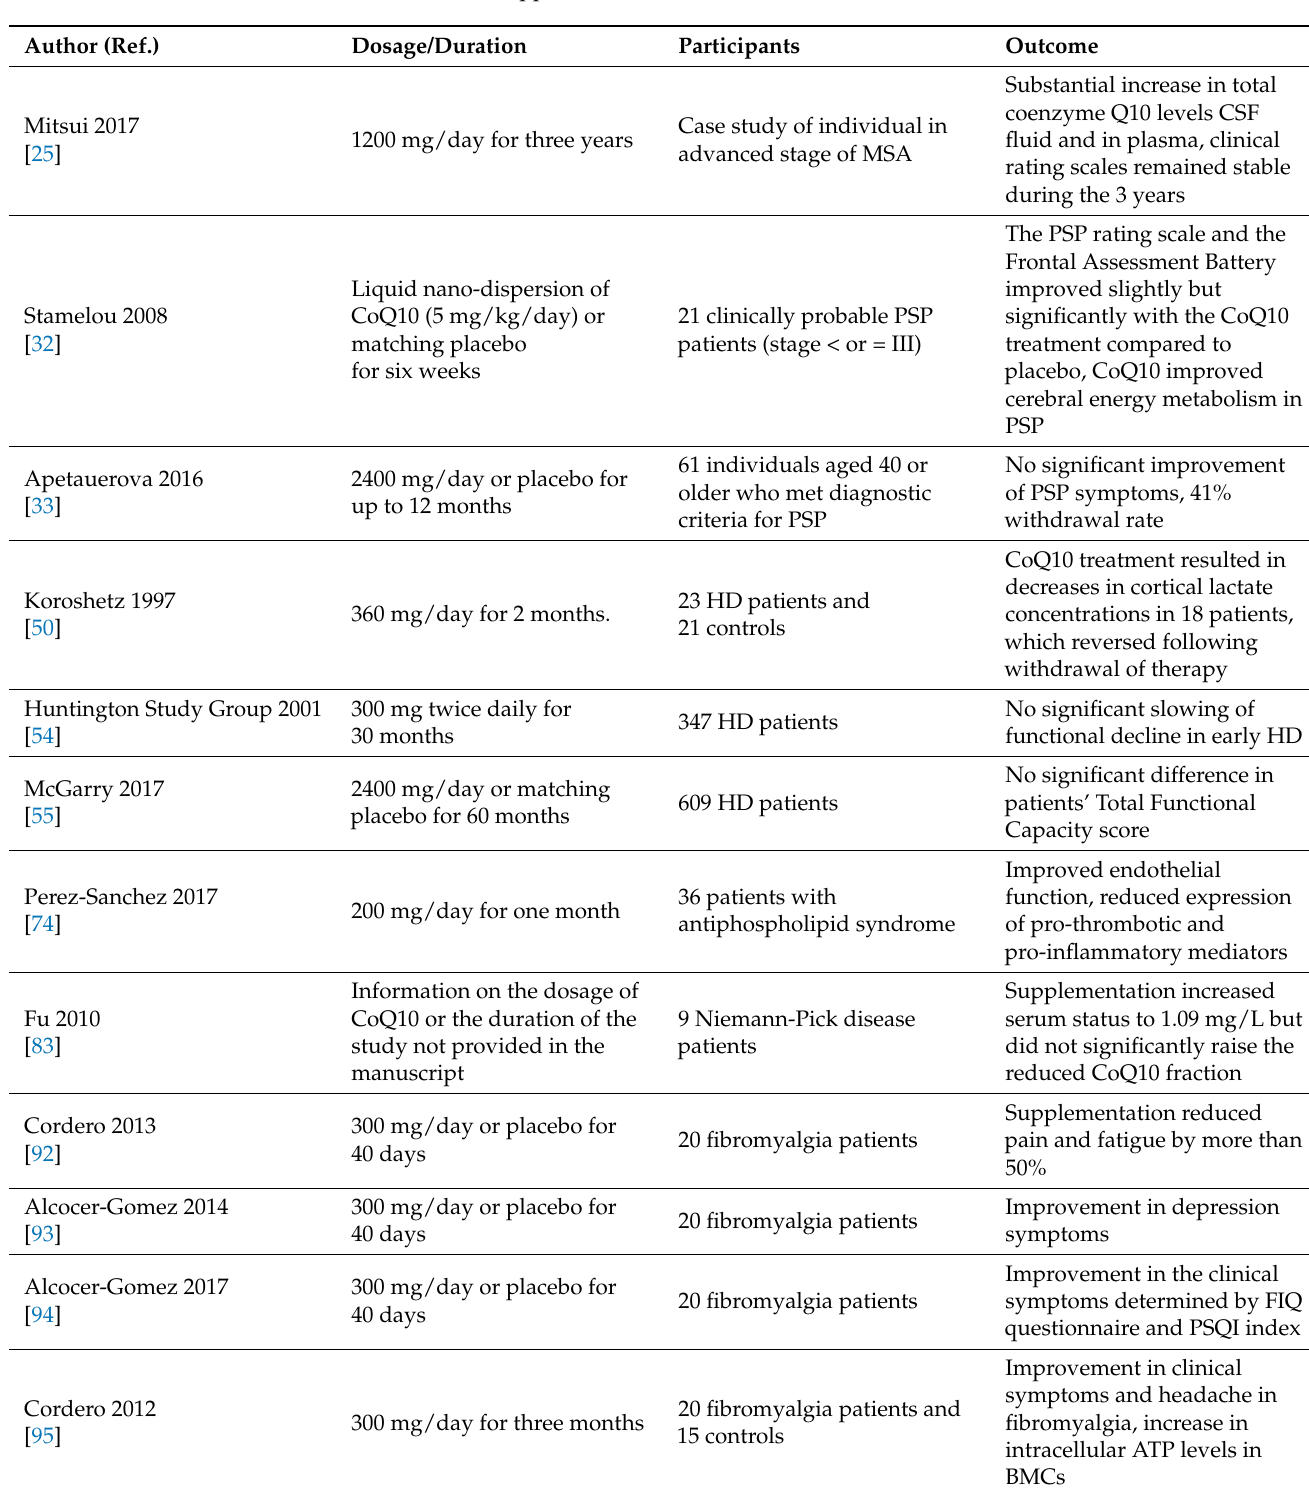
Table 2. CoQ10 Supplementation